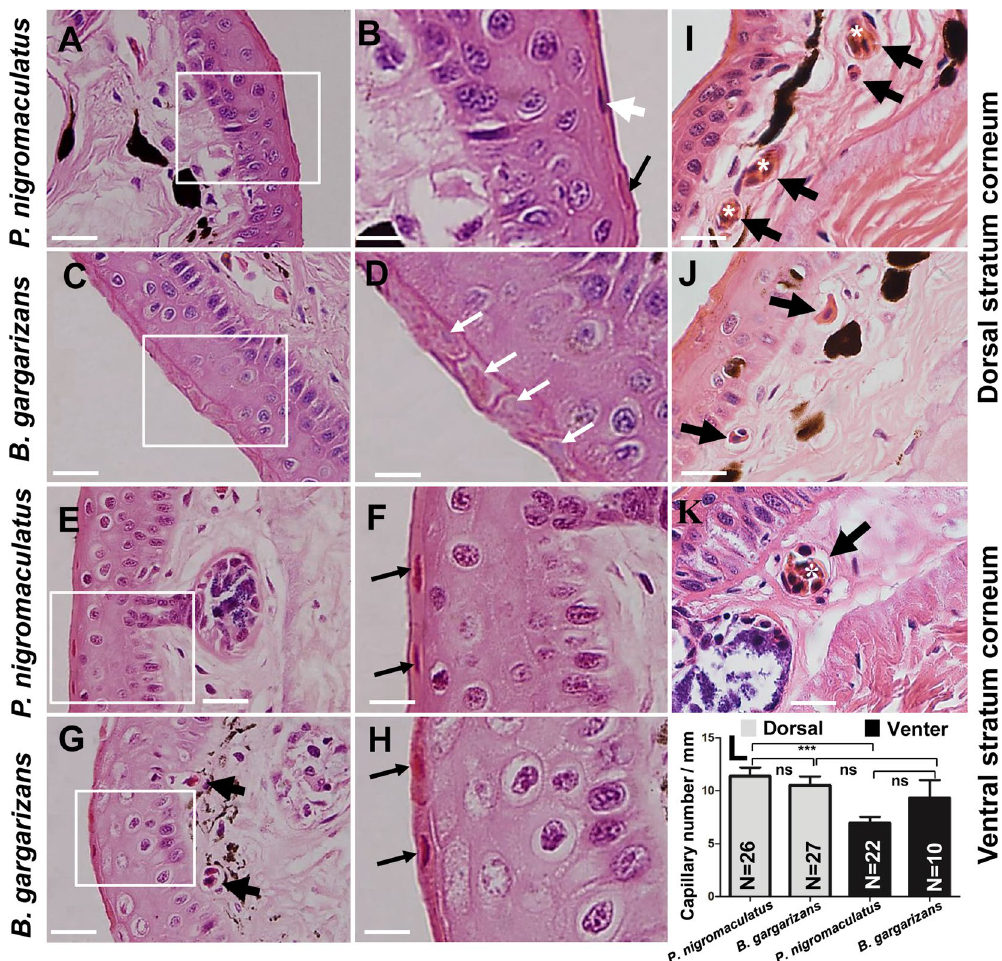
Figure 10. The stratum corneum and capillary in P. nigromaculatus and B. gargarizans by LM. LM observations of the stratum corneum and capillaries in P. nigromaculatus and B. gargarizans . The nucleus of the stratum corneum has a dark red or dark-purple-blue color ( A,B ) in the dorsal skin of P. nigromaculatus and almost completely disappears, leaving behind a light-blue residue ( C,D ), in B. gargarizans . The nucleus of the stratum corneum has a dark-red color in the ventral skin of P. nigromaculatus ( E,F ) and B. gargarizans ( G,H ). Capillaries in P. nigromaculatus ( I,J ) and B. gargarizans ( G,K ). Capillary density in P. nigromaculatus and B. gargarizans ( L ). B, D, F, and H show enlarged images of the boxes in A, C, E, and G, respectively. The white thick arrow shows a dark-purple nucleus, and the black thin arrow shows a dark-red nucleus. The white thin arrow shows the residue of the nucleus, and the black thick arrow shows a capillary. Asterisks show larger capillaries, which contain several red blood cells. Scale bar, A, C, E, G, I, J, K: 20 μ m; B, D, F, H: 7 μ